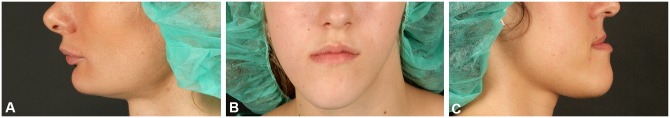
Screenshots of three dysgnathic patients [Class II (A); Laterognathia (B), and Class III (C)], presented to the raters in the video.